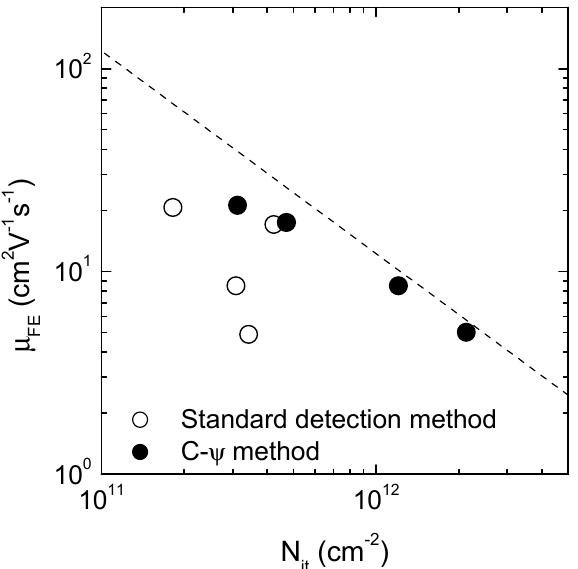
Figure 4. Experimental field e ff ect mobility µ FE values as a function of the integral of the interface state density ( N it ) evaluated with di ff erent methods. A clear correlation is obtained when N it is evaluated using the C- ψ method. The data were taken from Reference